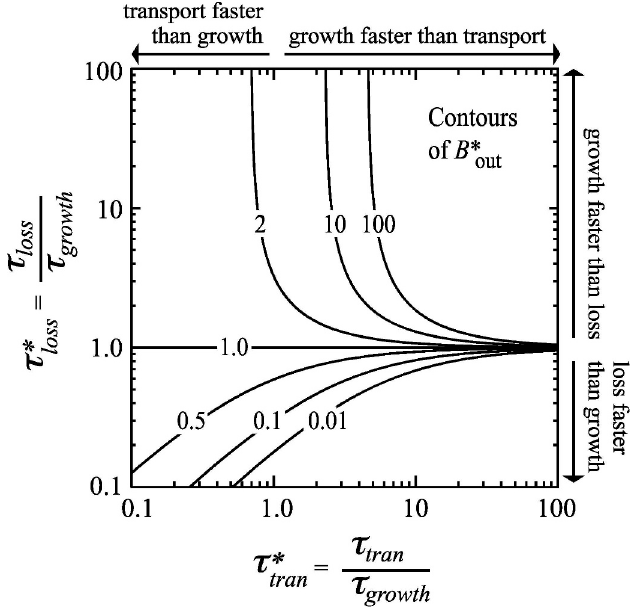
Figure 15. Contours of B ∗ , the ratio of outgoing algal biomass concentration to incoming concentration, as a function of two dimensionless parameters, τ ∗ (the ratio of the algal loss timescale to the growth timescale) and τ ∗ (the ratio of the transport timescale to the algal growth timescale). Based on the simple, timescale-based mathematical model of [23], Equation (7) herein. (From Lucas et al. [23]).